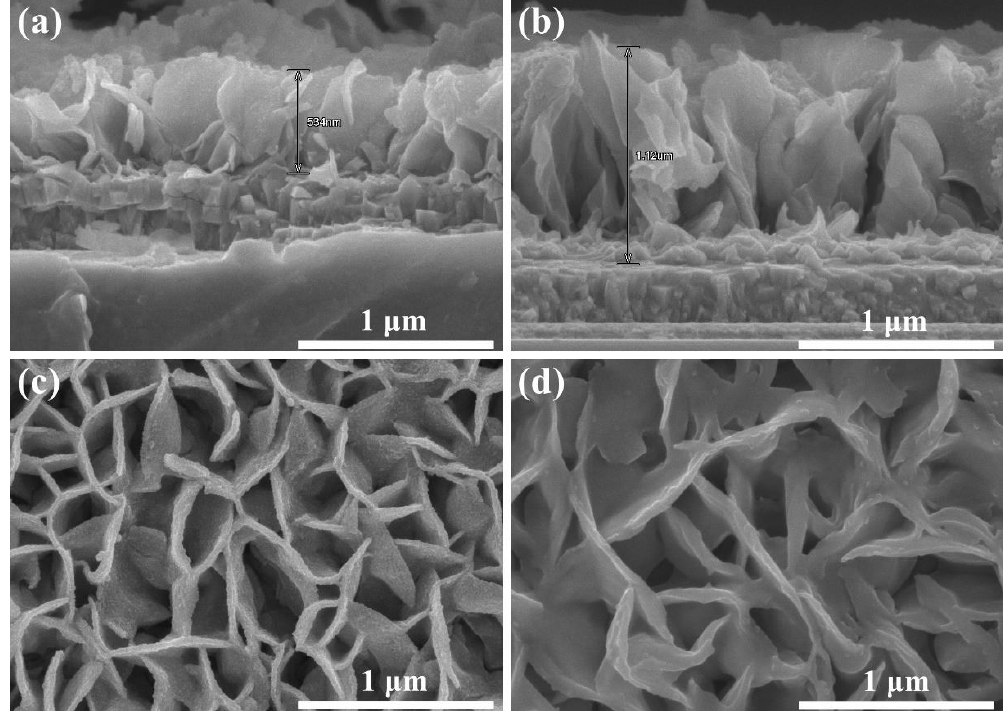
Figure 2. Cross-sectional view of field-emission scanning electron microscopy (FESEM) image of pristine SnS 2 film on FTO prepared at 60 °C for ( a ) 1 h, and ( b ) 1.5 h, ( c , d ) are the corresponding top-view SEM images.